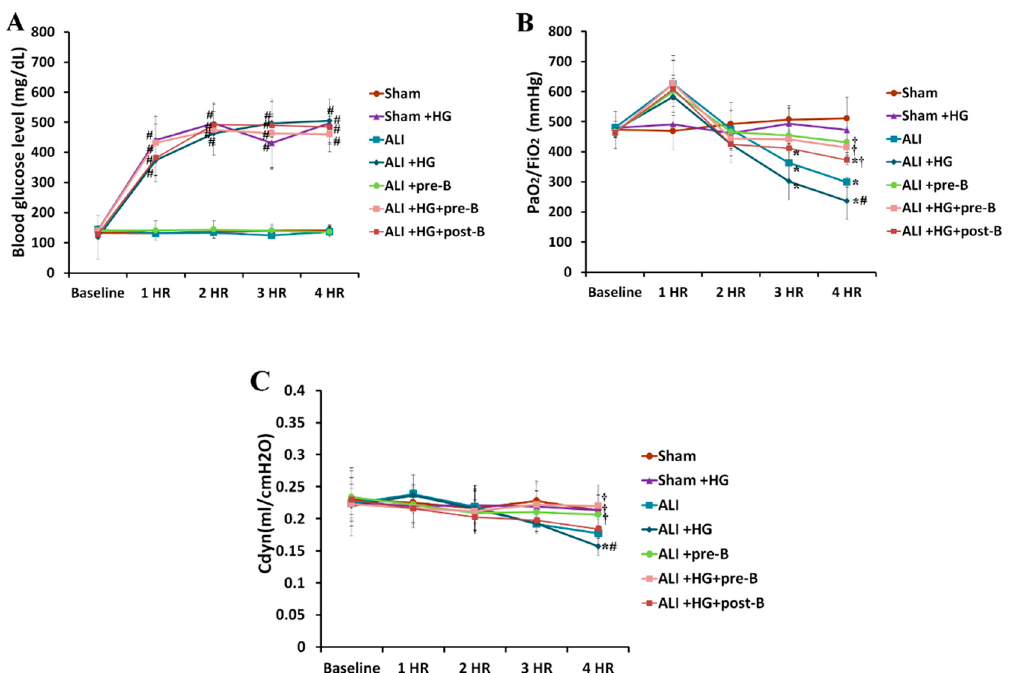
Figure 1. Blood glucose levels, oxygenation, and dynamic compliance of lungs. The blood glucose levels ( A ) in the hyperglycemic rats were 400–500 mg/dL, which were significantly higher than that in non-hyperglycemic rats ( p < 0.05). PaO 2 /FiO 2 ( B ) was significantly reduced in rats with ALI or ALI + HG ( p < 0.05). PaO 2 /FiO 2 was lower in rats with ALI + HG than in rats with ALI ( p < 0.05). The rats that received the NKCC1 inhibitor had higher PaO 2 /FiO 2 than those without NKCC1 inhibitor ( p <